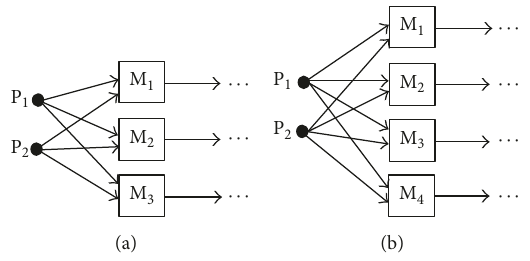
Figure 5: MPC consisting of (a) three machines and two parts and (b) four machines and two parts.